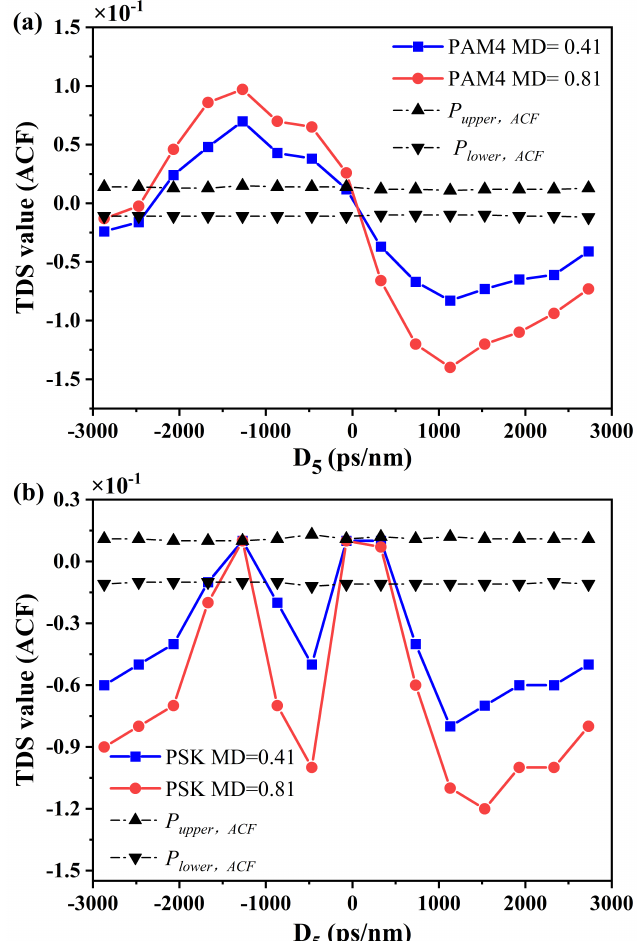
Figure 3. ( a ) TDS peak value of the ACF curve versus D5 for the PAM4 signal and ( b ) for PSK modulation signal with different